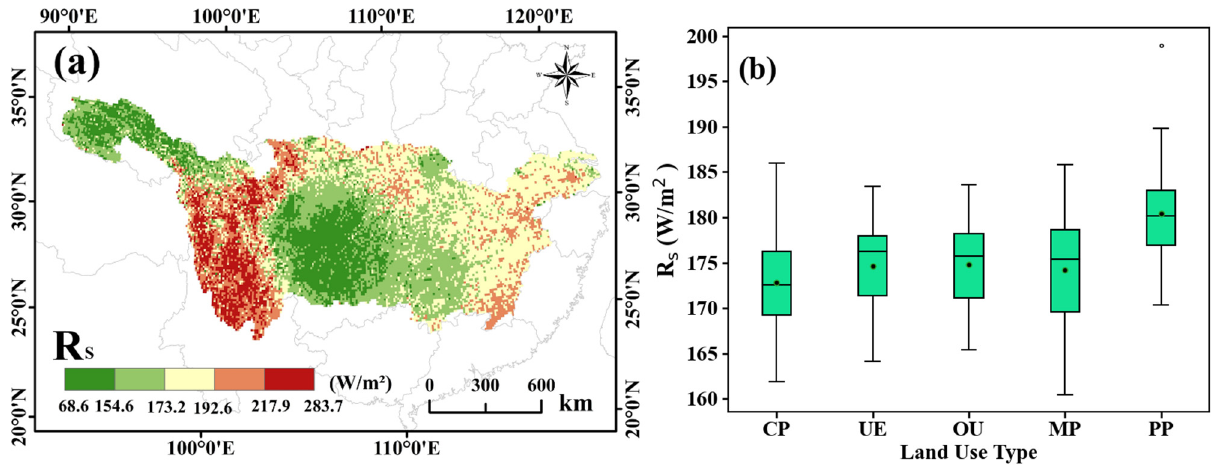
Figure 6. ( a ) Spatial variation in net radiation (R s ) in the Yangtze River basin from 2000–2020 and ( b ) statistical values for the five use types.